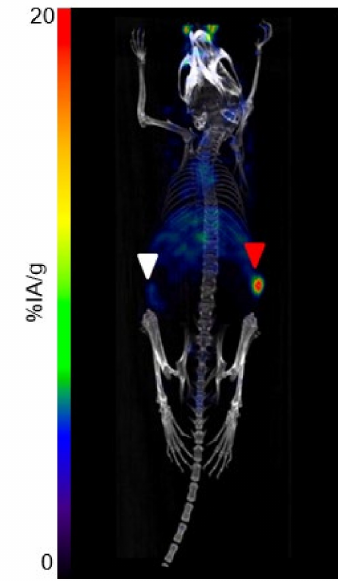
Figure 2. [ 64 Cu]Cu-1C1m-Fc dorsal view PET/CT fusion maximum intensity projection in mouse bearing TEM-1-positive tumors (SK-N-AS, left flank, red arrow), ( a ) at 4 h, ( b ) at 24 h, ( c ) at 48 h.